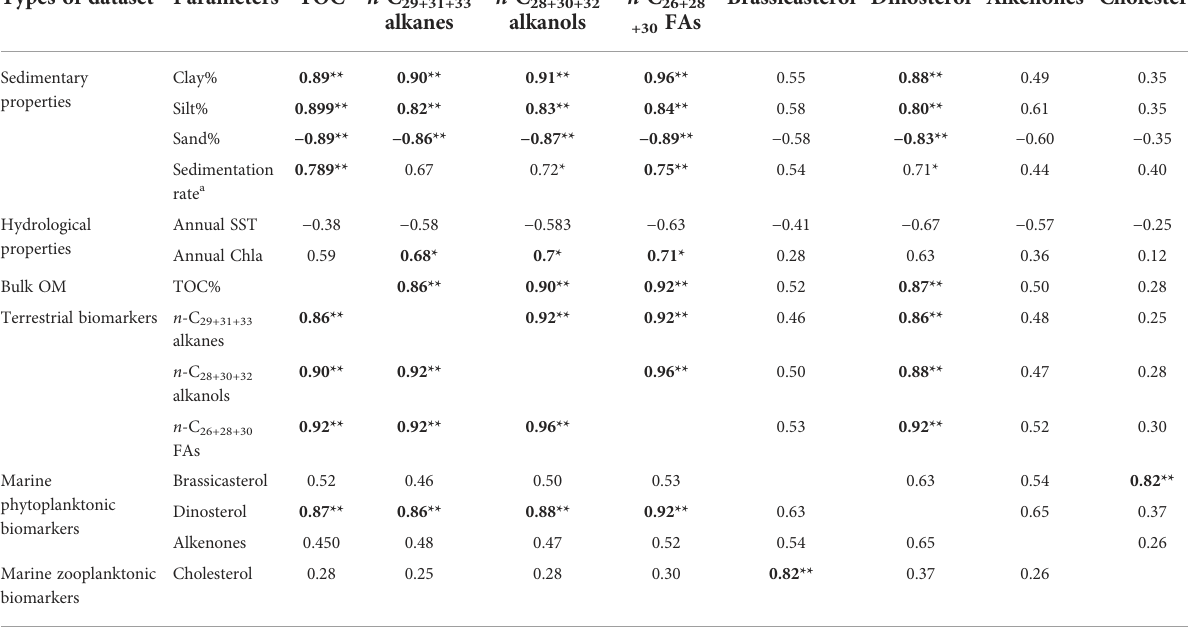
TABLE 2 Cross-correlation coef fi cient (R) for the parameters of sedimentary properties, hydrological properties, TOC, and source-speci fi c lipid biomarker contents in surface sediments from the TS. Types of dataset Parameters TOC n -C 29+31+33